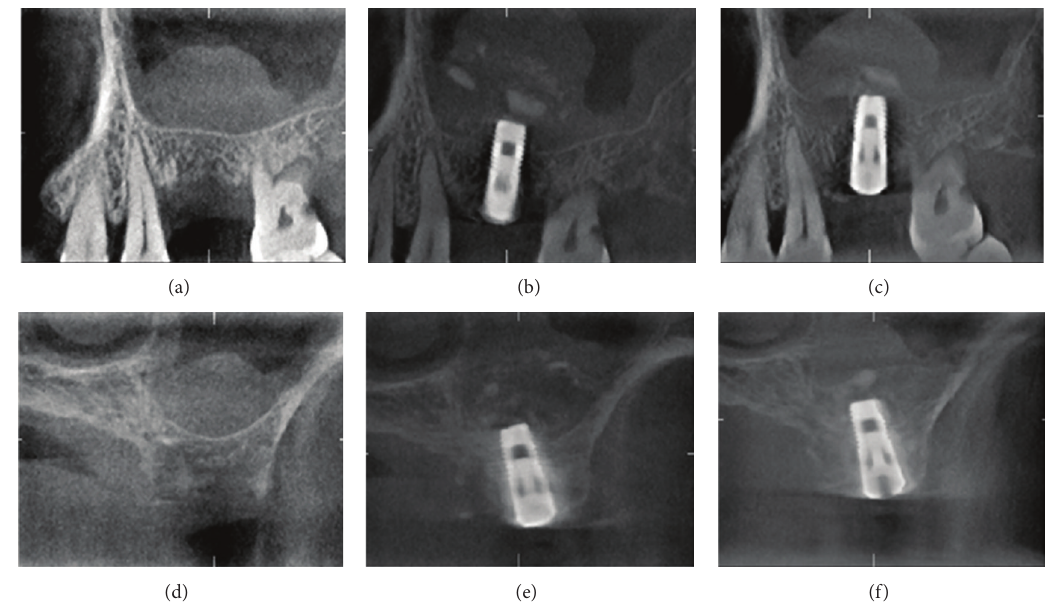
Figure 2: Representative CBCT images. Parallel section to dental arch (a) preoperatively and at the first (b) and second (c) operations. Cross- section to dental arch (d) preoperatively and at the first (e) and second (f) operations.